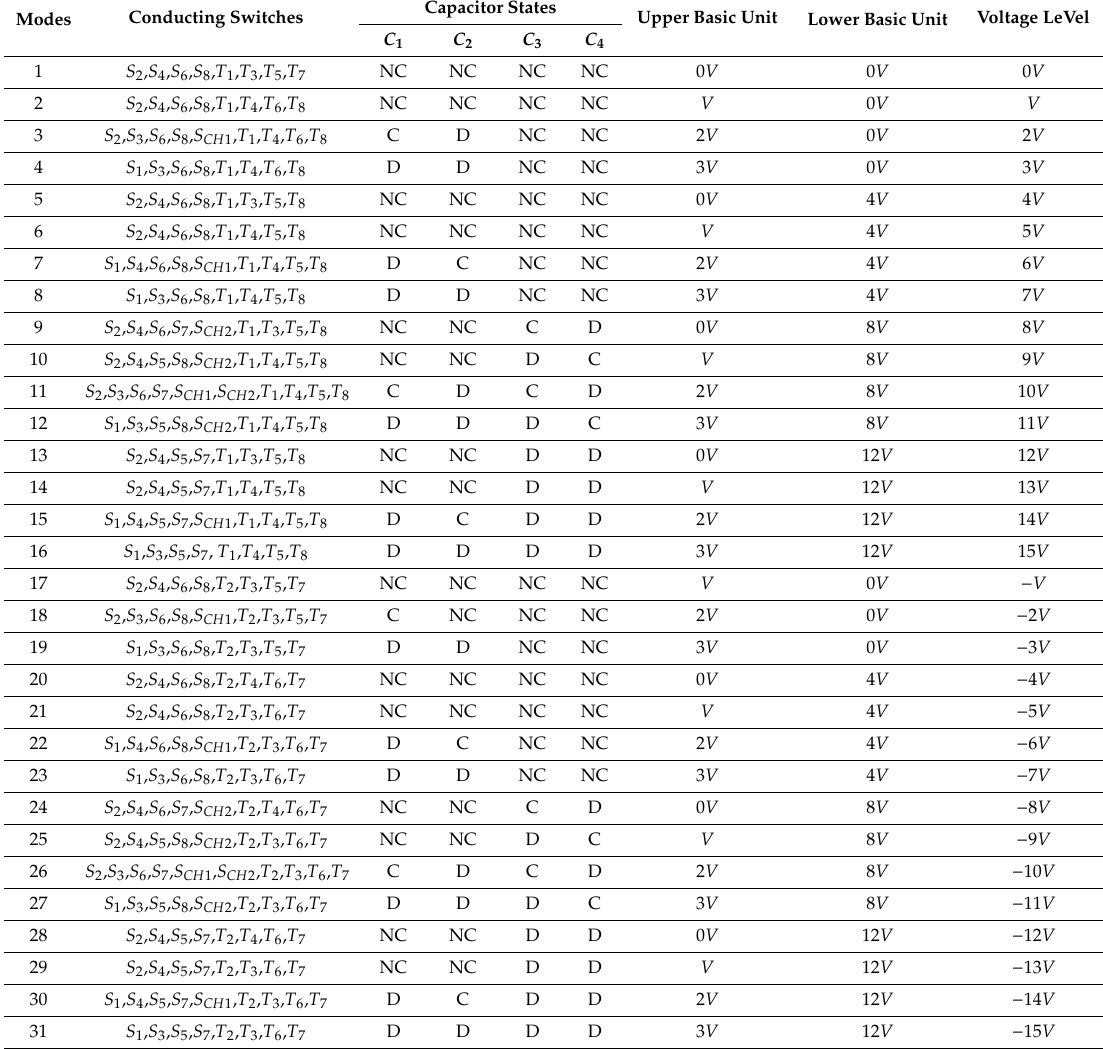
Table 3. Switching for the generation of 31 voltage level.